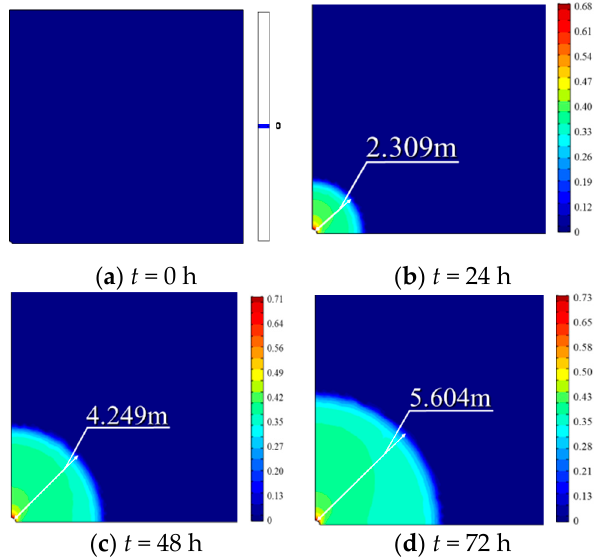
Figure 12. Spatial evolution of the damage area of strata at different times. ( a ) Damage area at t = 0 h; ( b ) Damage area at t = 24 h; ( c ) Damage area at t = 48 h; ( d ) Damage area at t = 72 h.